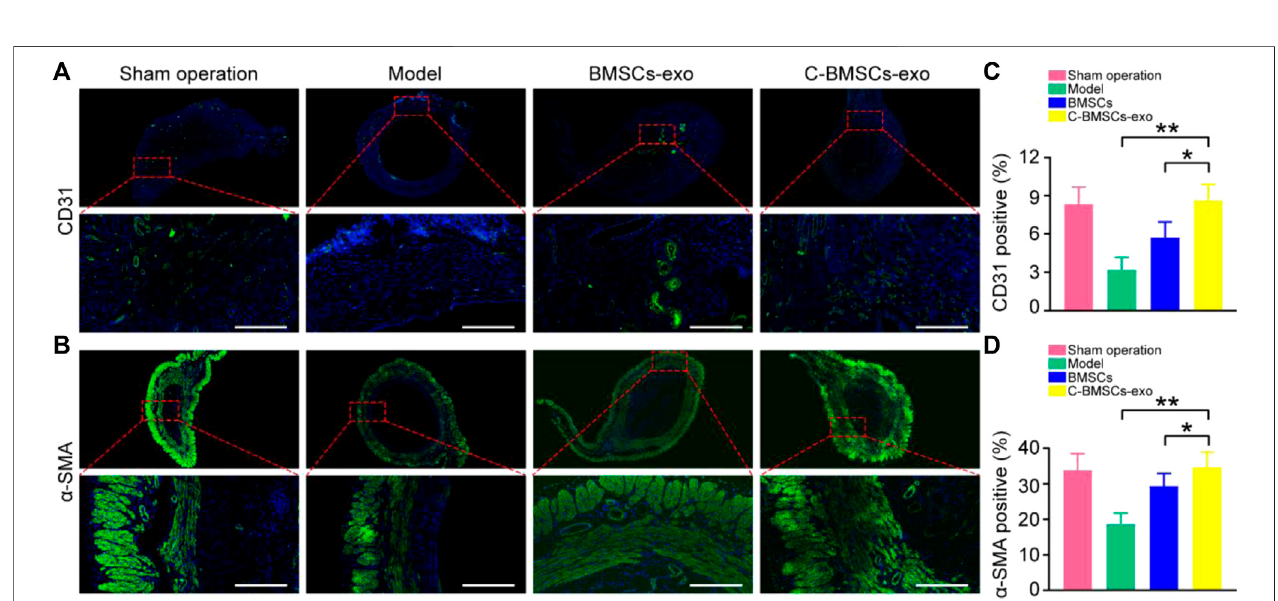
FIGURE6| BMSCs-exoorC-BMSCs-exoadministrationinducesendometrialneovascularizationandmyometrialregeneration. (A) CD31-positiveendothelialcells were detected via immuno fl uorescent staining in the indicated treatment groups (Scale bar: 100 µm). (B) Smooth muscle was assessed via α -SMA staining to assess myometrial regeneration (Scale bar: 100 µm). (C,D) CD31 and α -SMA expression were quanti fi ed ( n = 3 mice per group from three independent experiments). Data are means ± Standard deviation. * p < 0.05, ** p < 0.01.